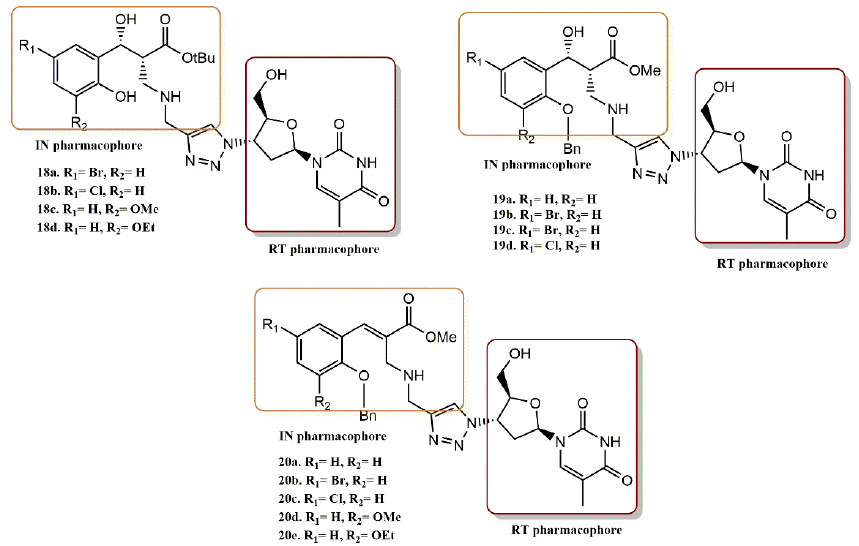
Figure 19. RT and IN pharmacophores of new active synthesized compounds 18a-d , 19a-d and 20a- e